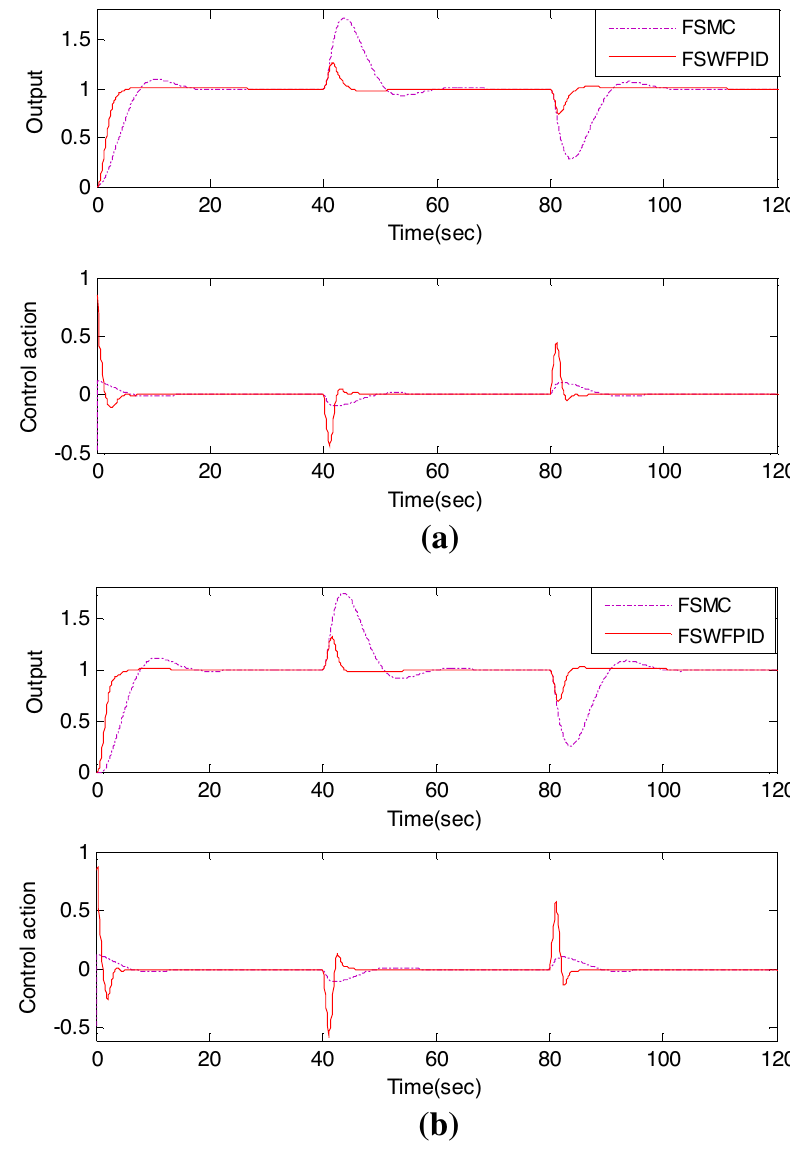
Fig. 19 Comparison among responses and control actions for Model IV with FSMC using 25 rules during set point response and with load varia- tion for a L = 0.1 s, b L = 0.3